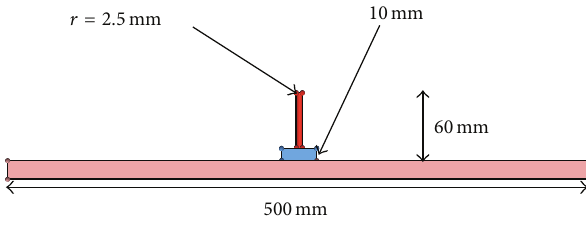
Figure 5: The geometry of the monopole antenna mounted on a PEC